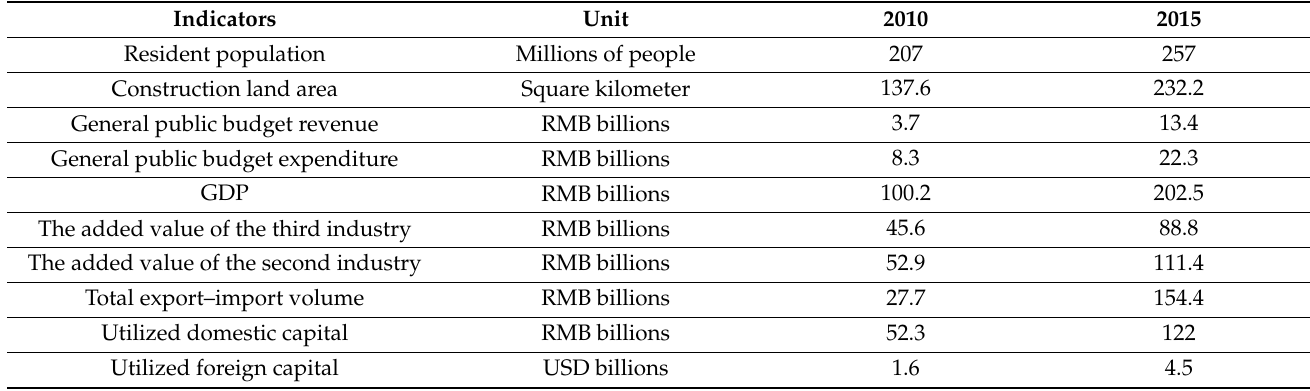
Table 1. Key social and economic indicators for the LNNA, 2010–2015 (source: author’s own compilation based upon the statistical bulletin of the Liangjiang National New Area).